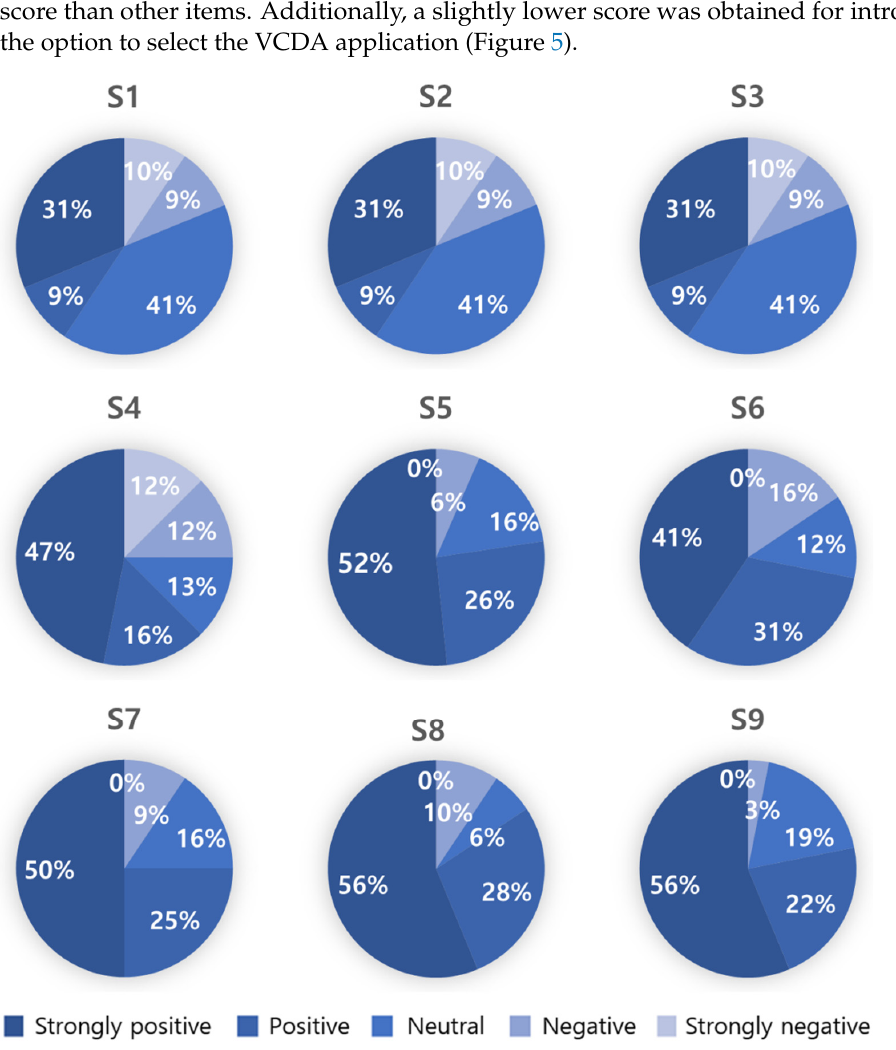
Figure 5. Satisfaction survey results with VCDA.